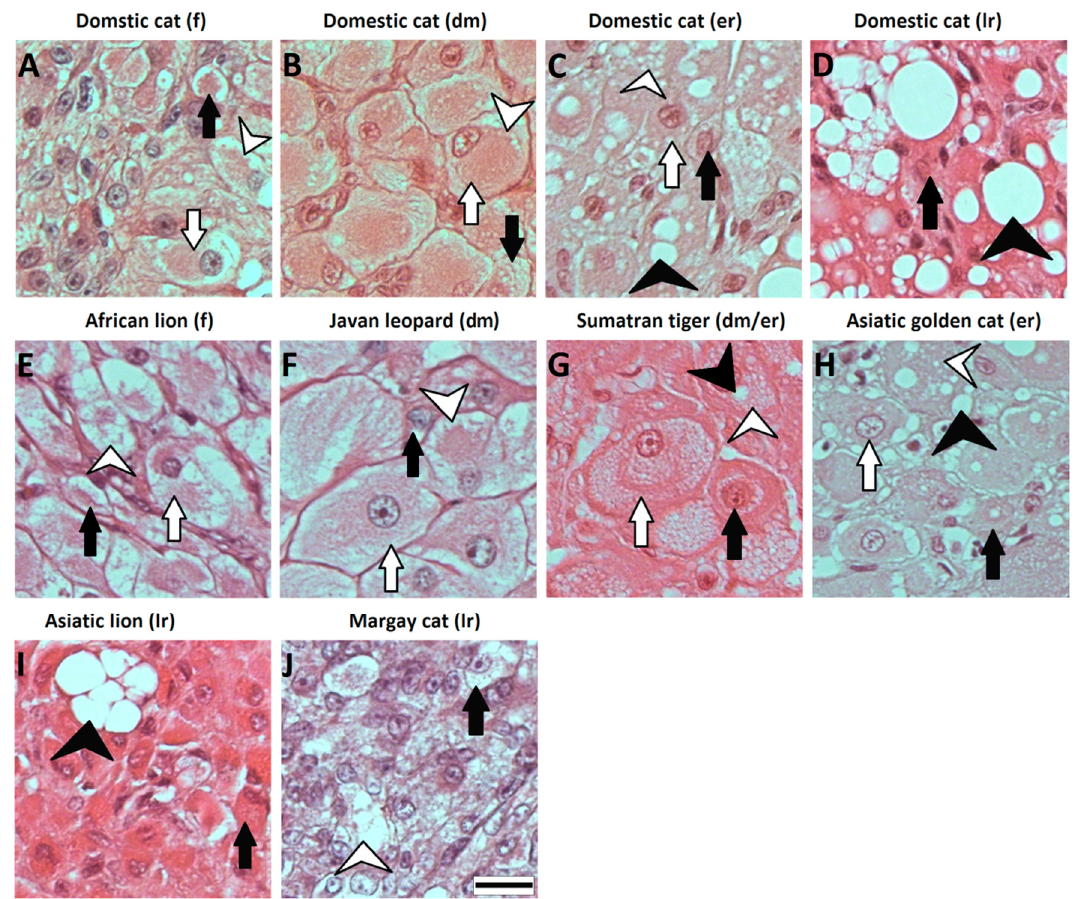
Figure 1. Hematoxylin and eosin staining of corpus luteum (CL) from domestic cat ( A – D ) and wild felid ( E – J ) species at different developmental stages. ( A ) CL from the domestic cat in the formation stage—luteal cells have different sizes and shapes, from elongated to round or polyhedral. Small vacuoles are present in the cell cytoplasm; ( B ) CL from the domestic cat in the development/maintenance stage—luteal cells are fully grown, have a polyhedral shape and contain high degree of small vacuoles; ( C ) CL from the domestic cat in the early regression stage—luteal cells contain small and large vacuoles and their shape may be partly deformed; ( D ) CL from the domestic cat in the late regression stage—luteal cells are deformed because of the presence of high numbers of large vacuoles; ( E ) CL from the African lion in the formation stage—luteal cells have different sizes and small vacuoles; ( F ) CL from the Javan leopard in the development/maintenance stage—luteal cells are large or medium-sized and have polyhedral shape, indicating a development rather than a maintenance stage; ( G ) CL from the Sumatran tiger in the development/maintenance–early regression stage—luteal cells have a degree of small vacuoles with single large vacuoles in some of the cells; ( H ) CL from the Asiatic golden cat in the early regression stage—luteal cells have a round or polyhedral shape with large and small vacuoles; ( I ) CL from the Asiatic lion in the late regression stage—single small (SLC) or large (LLC) luteal cells with a round shape are visible, but most of the cells are small and deformed. Rare large vacuoles are visible; ( J ) CL from Margay cat in the late regression stage—single SLC or LLC with an oval shape are visible while other cells are densely packed. A black arrow indicates SLC; a white arrow indicates LLC; a white arrow head indicates small vacuoles; a black arrow head indicates large vacuoles. f—formation, dm—development/maintenance, er—early regression, lr—late regression. Scale bar is equal to 20 µm.